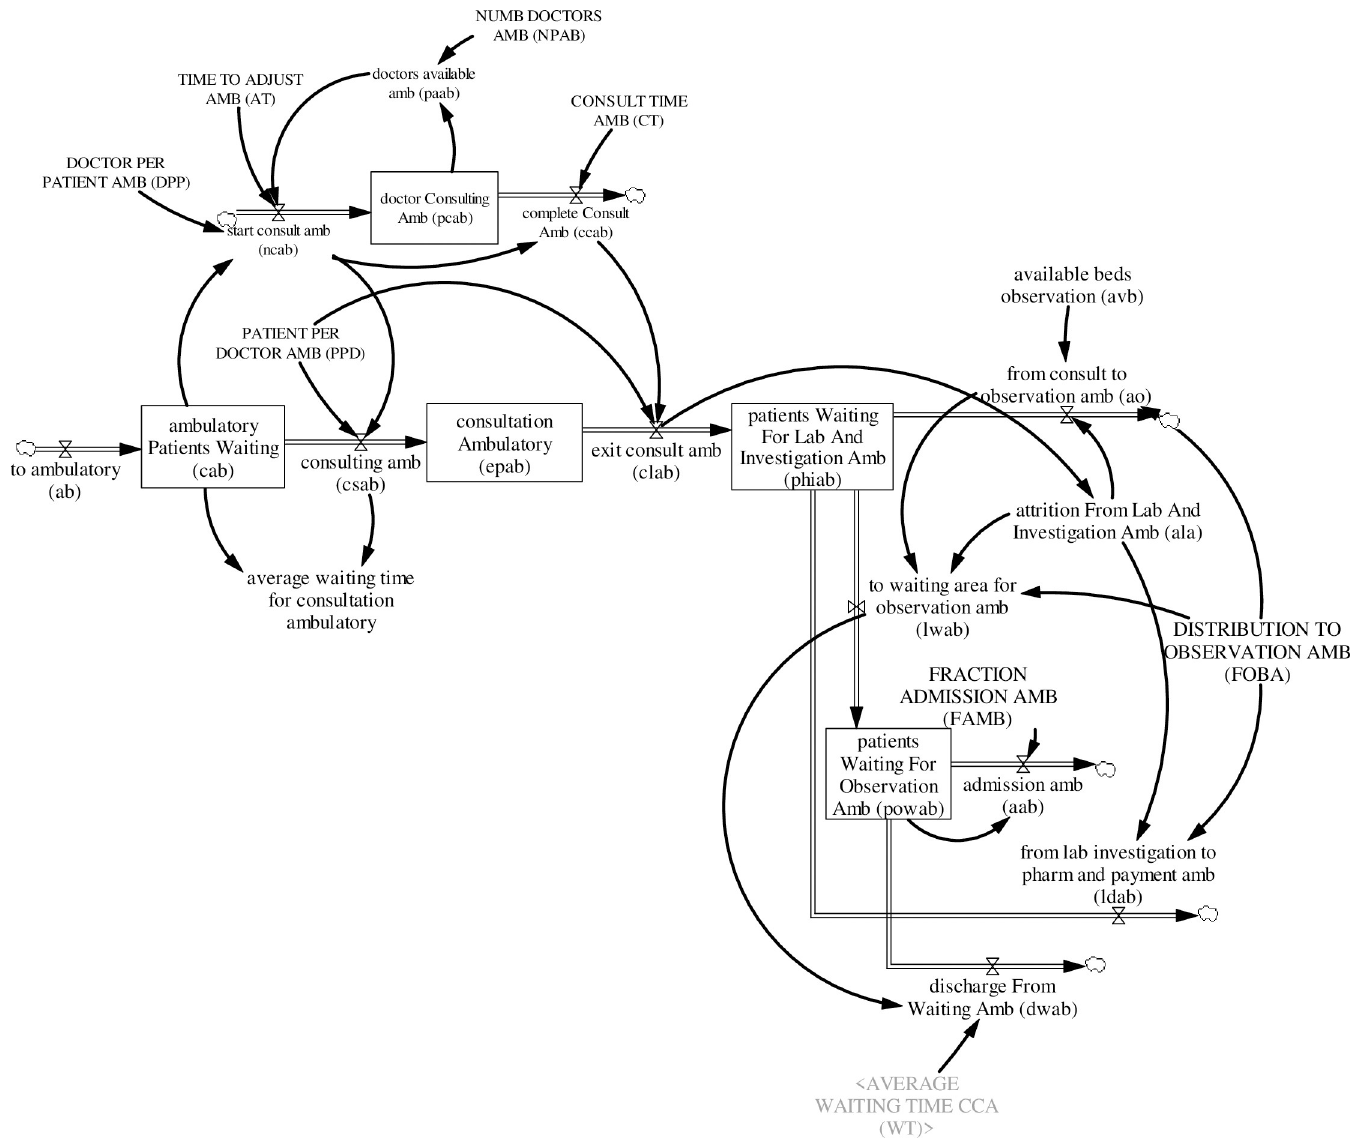
Fig 7. Ambulatory care area